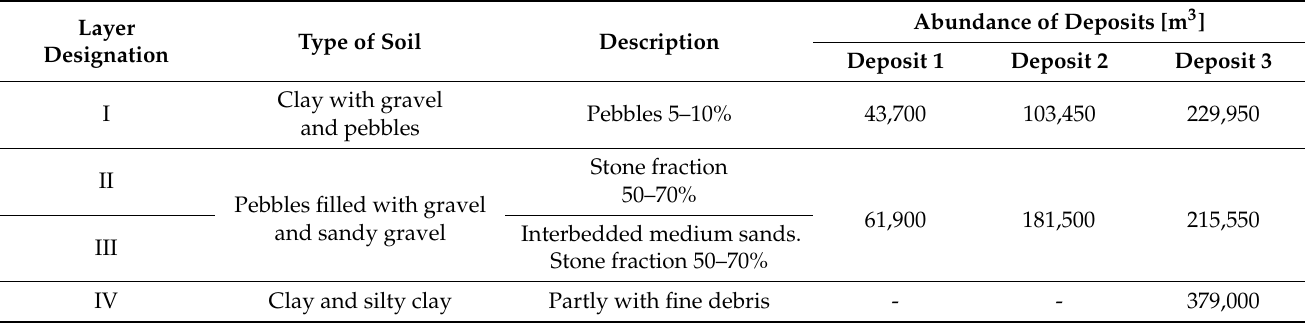
Figure 1. Location of soil deposits within the reservoir basin (internal analysis based on [42]). Table 2. Characteristics of soil layers and their identification in deposits [42].